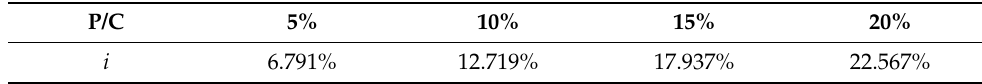
Table 4. Reduction of cement paste in the unit volume of mortar ( i ).